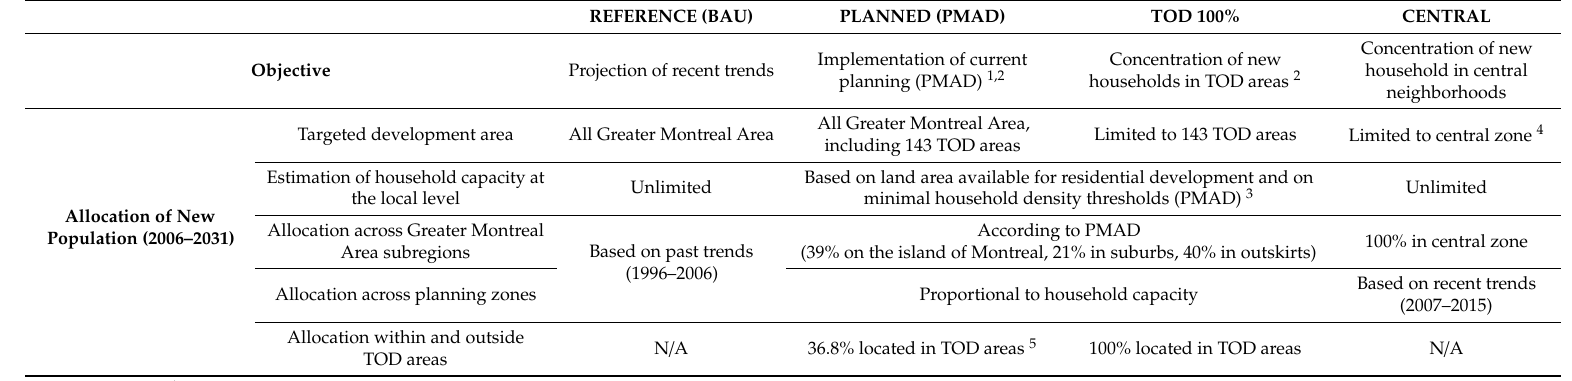
Table 1. Scenarios’ main objective and allocation of new population